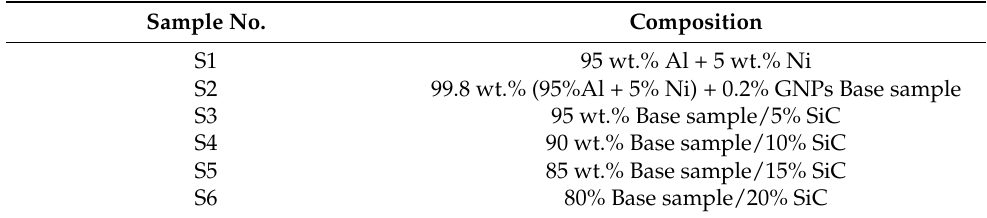
Table 2. Composition of the nanocomposite specimens. Sample